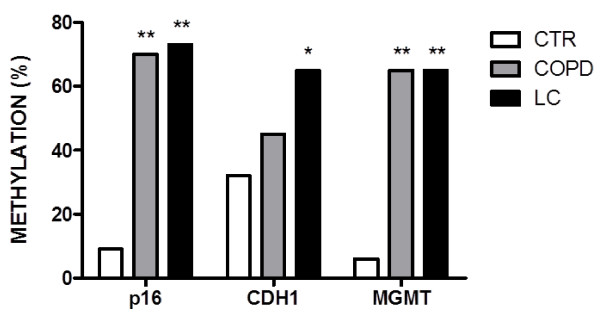
Representative analysis of methylation promoter frequency from sputum samples from CTR, COPD and LC subjects. Methylation promoter frequency (%) for p16, CDH1 and MGMT in COPD and LC group, both compared with CTR group. Group differences were assessed using Fisher’s test. ** P < 0.0001 respect to control group (CTR). * P < 0.05 respect to control group (CTR).